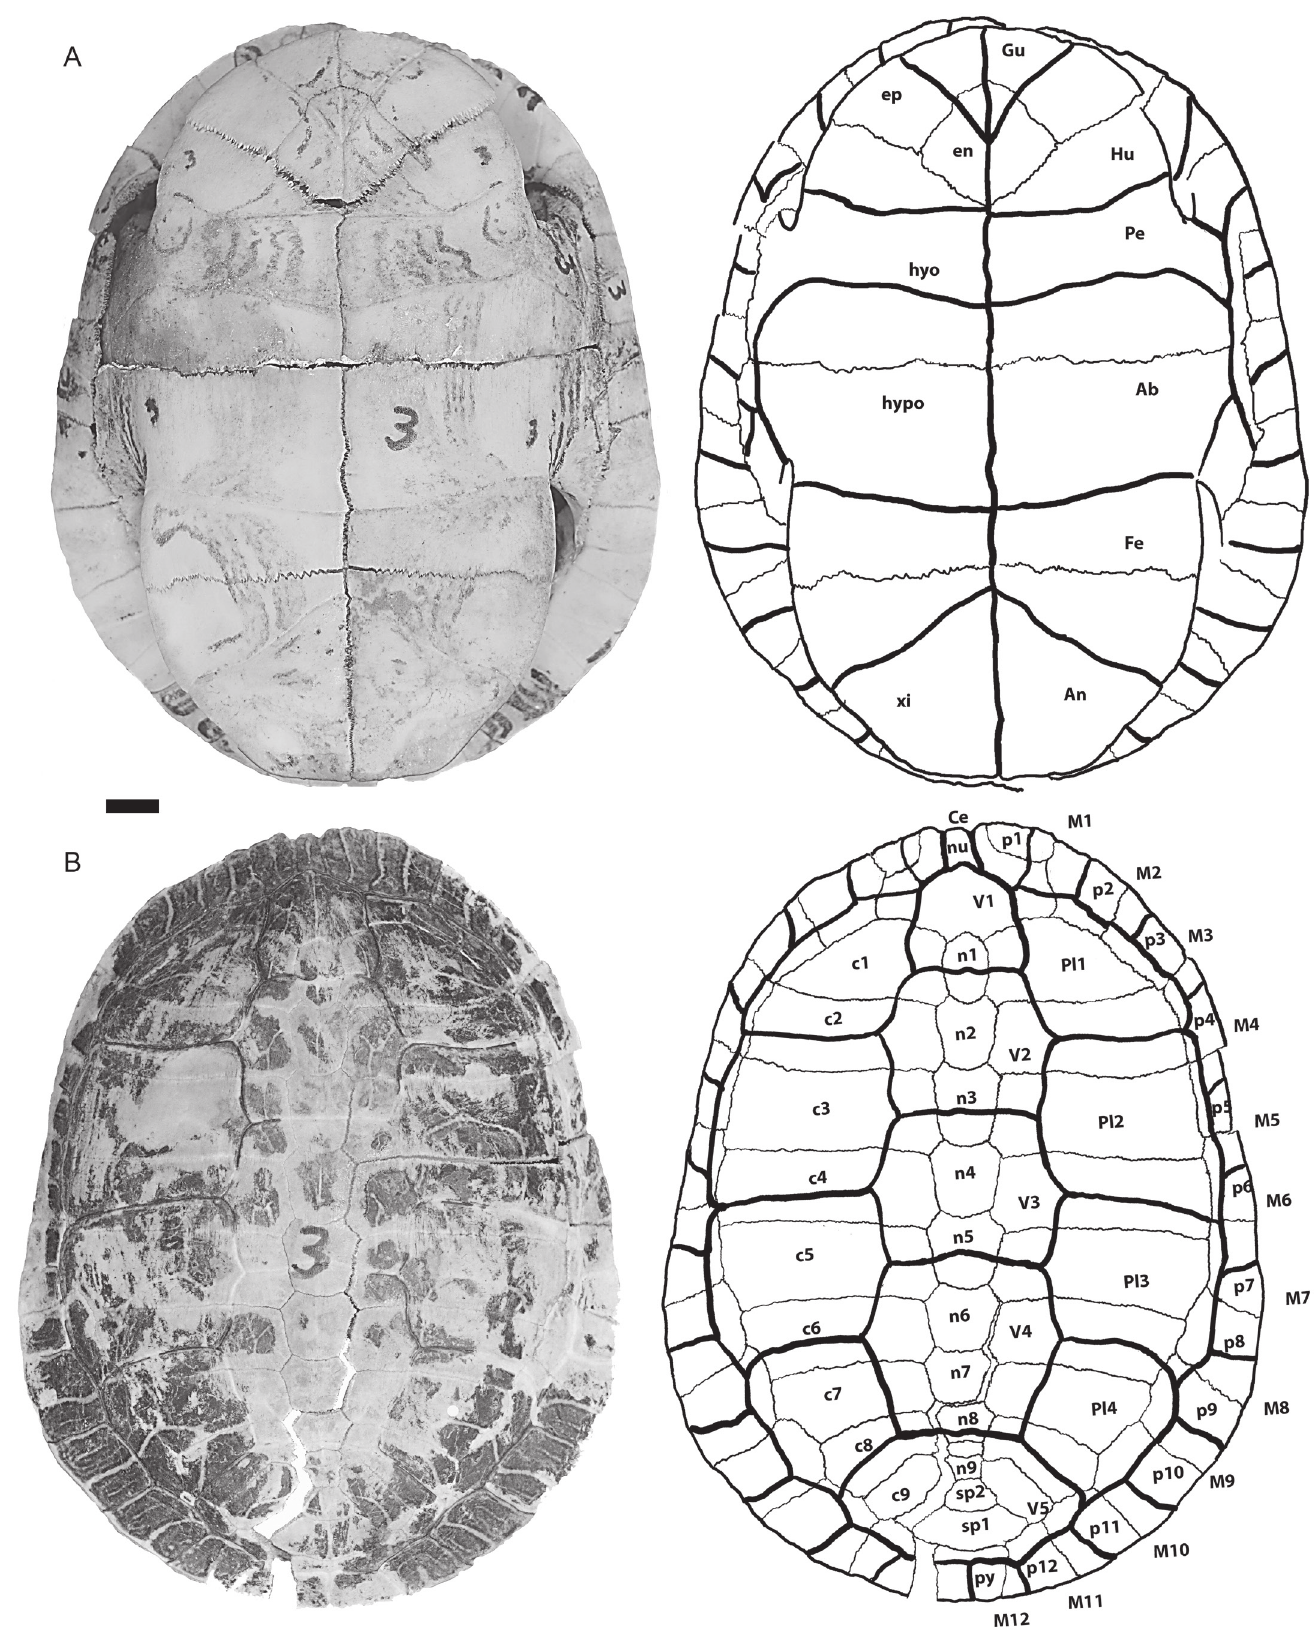
Figure 1. Chrysemys picta bellii, Neb 3. A, plastron and B, carapace. Abbreviations: Ab, abdominal scute; An, anal scute; c, costal; en, entoplastron; ep, epiplastron; Fe, femoral scute; Gu, gular scute; Hu, humeral scute; hyo, hyoplastron; hypo, hypo- plastron; n, neural; nu, nuchal; Pe, pectoral scute; py, pygal; sp, suprapygal; xi, xiphiplastron. Scale bar = 1